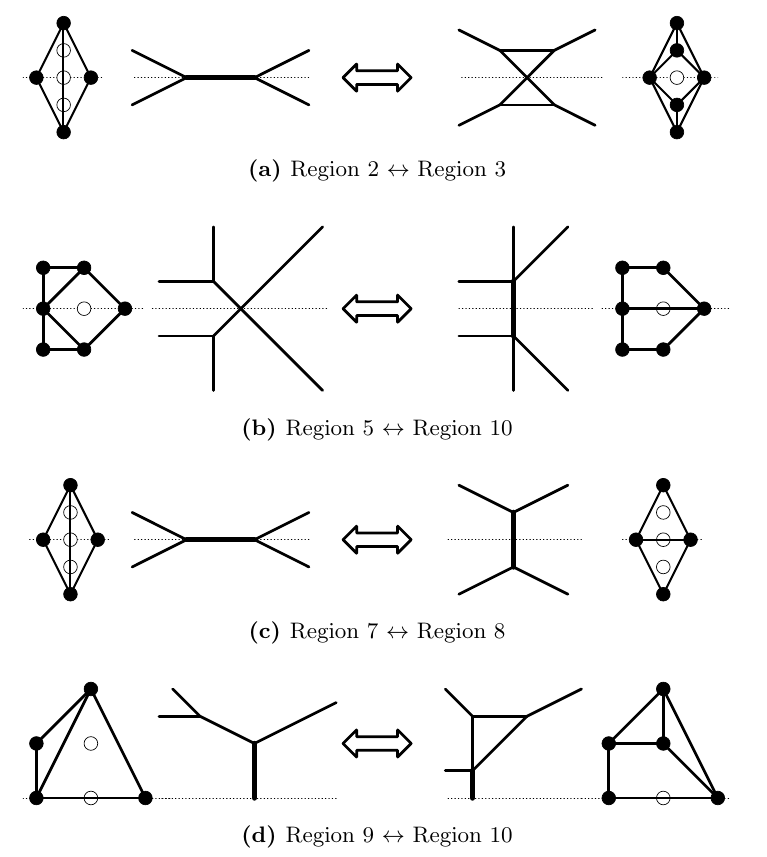
Figure 13. Four new transitions occurring in the phase diagram of the E 2 theory which can be interpreted as a generalized (cid:13)op transition on a 5-brane web diagrams with an O5-plane.